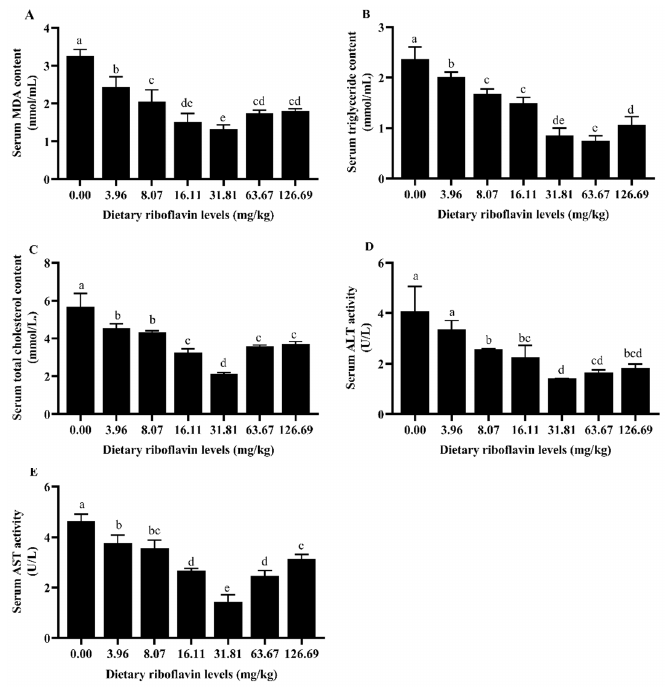
Figure 3. Effect of graded dietary riboflavin levels on serum MDA, triglyceride, total cholesterol, ALT and AST activities of coho salmon ( Oncorhynchus kisutch ) post-smolts for 12 weeks. ( A ) MDA; ( B ) triglycerides; ( C ) total cholesterol; ( D ) ALT; ( E ) AST. Values are expressed as the mean ± SD of three replicate groups. Means with different superscript letters are significantly different ( p < 0.05). Abbreviations: MDA, malondialdehyde; ALT, alanine aminotransferase; AST, aspartate ami- notransferase.